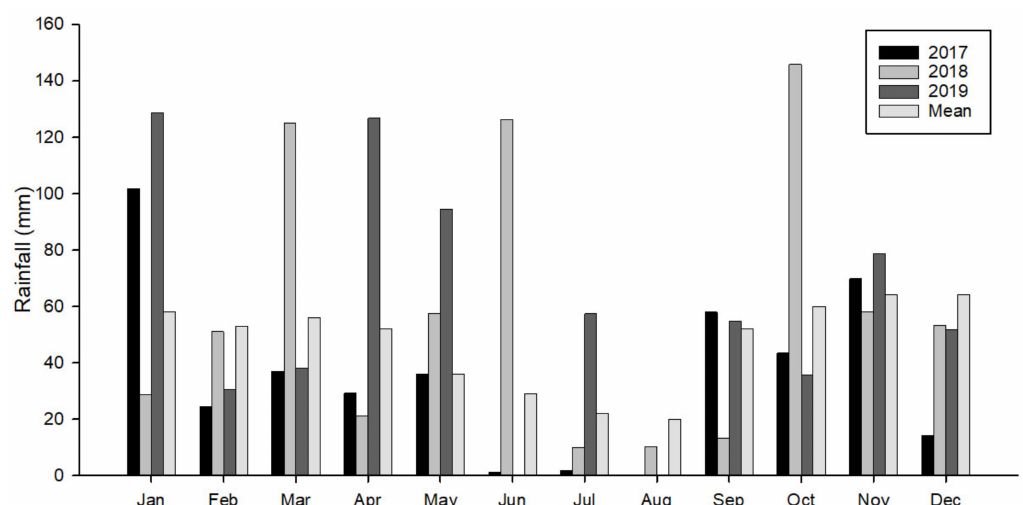
Figure 4. Monthly rainfall of the 2017–2019 and the pluriannual mean (mm).